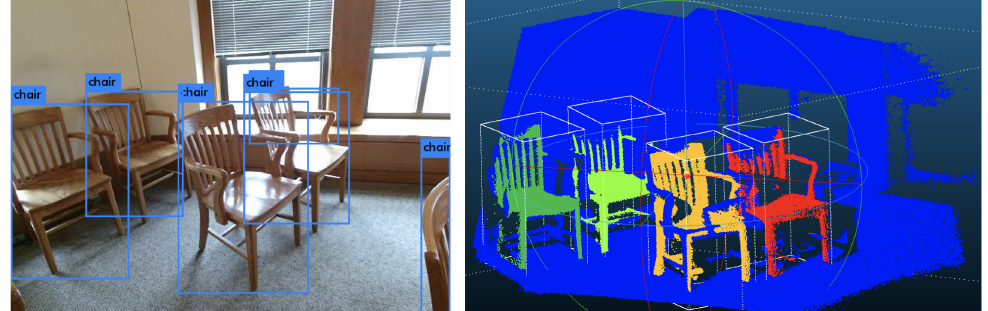
Figure 14. An example of 3D instance segmentation. The left image is the RGB color image and the right is the instance segmentation based on the point cloud. The image comes from the SUN RGB-D dataset and the instance segmentation visualization is based on the ground truth 3D segmentations.